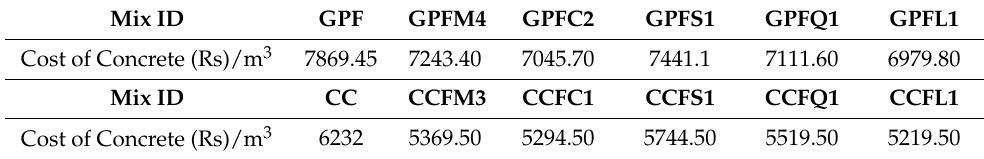
Table 8. Cost analysis for geopolymer concrete and cement concrete mixes.